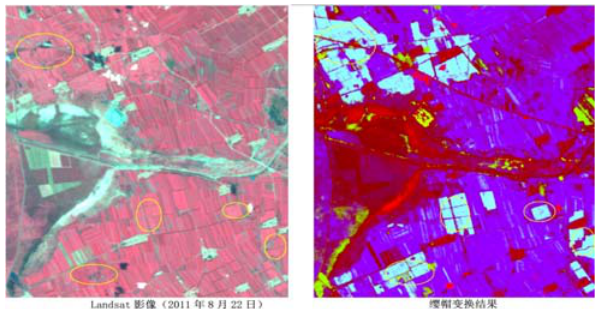
Figure 3. Image changes comparison of paddy field and dry